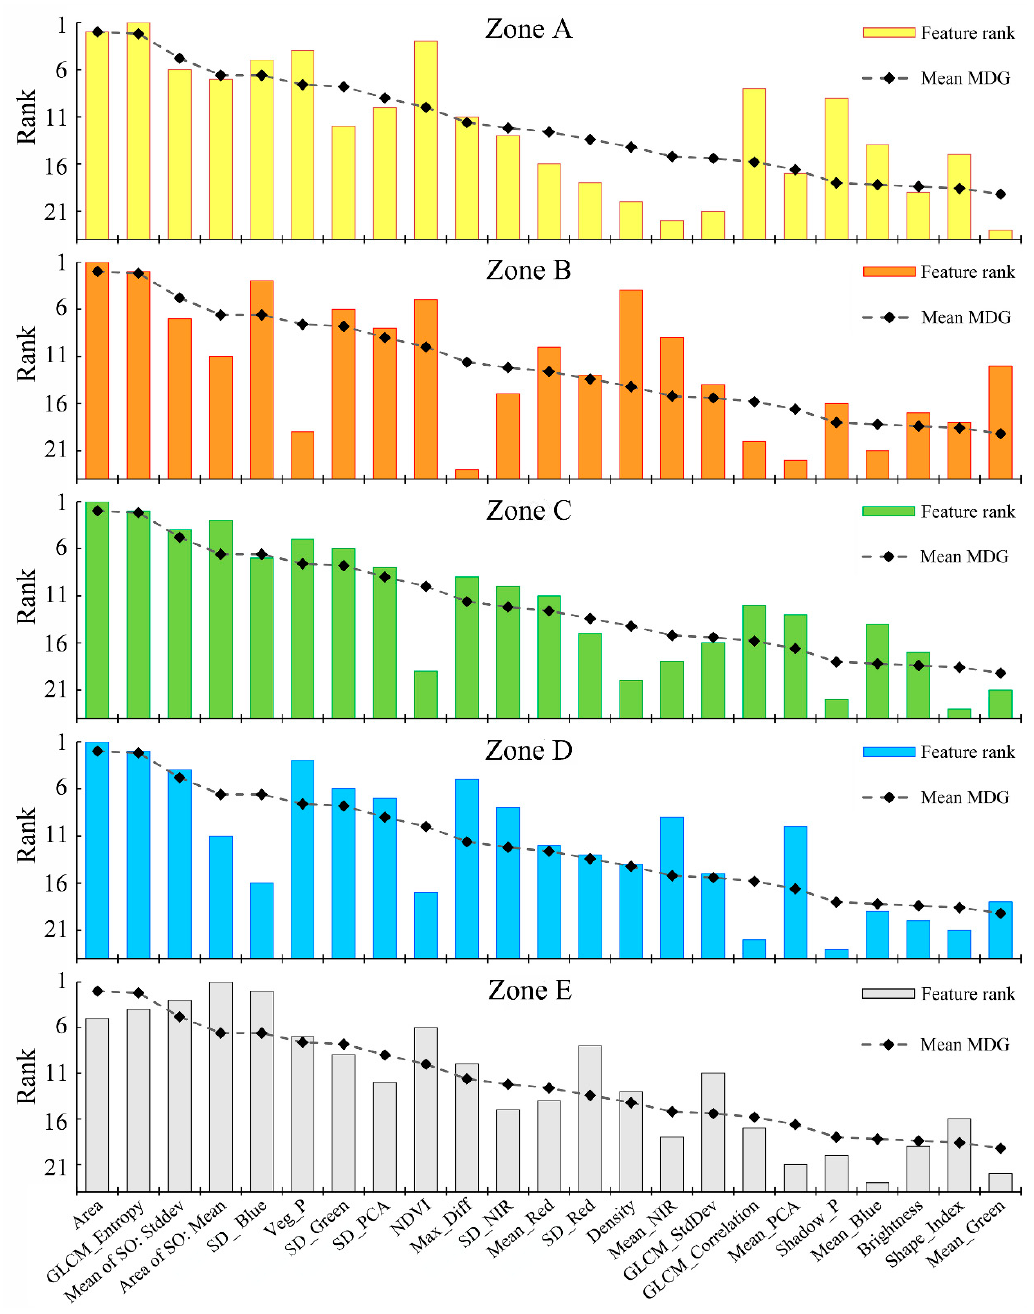
Figure 8. Feature significance ranks in five zones (zones A–E).